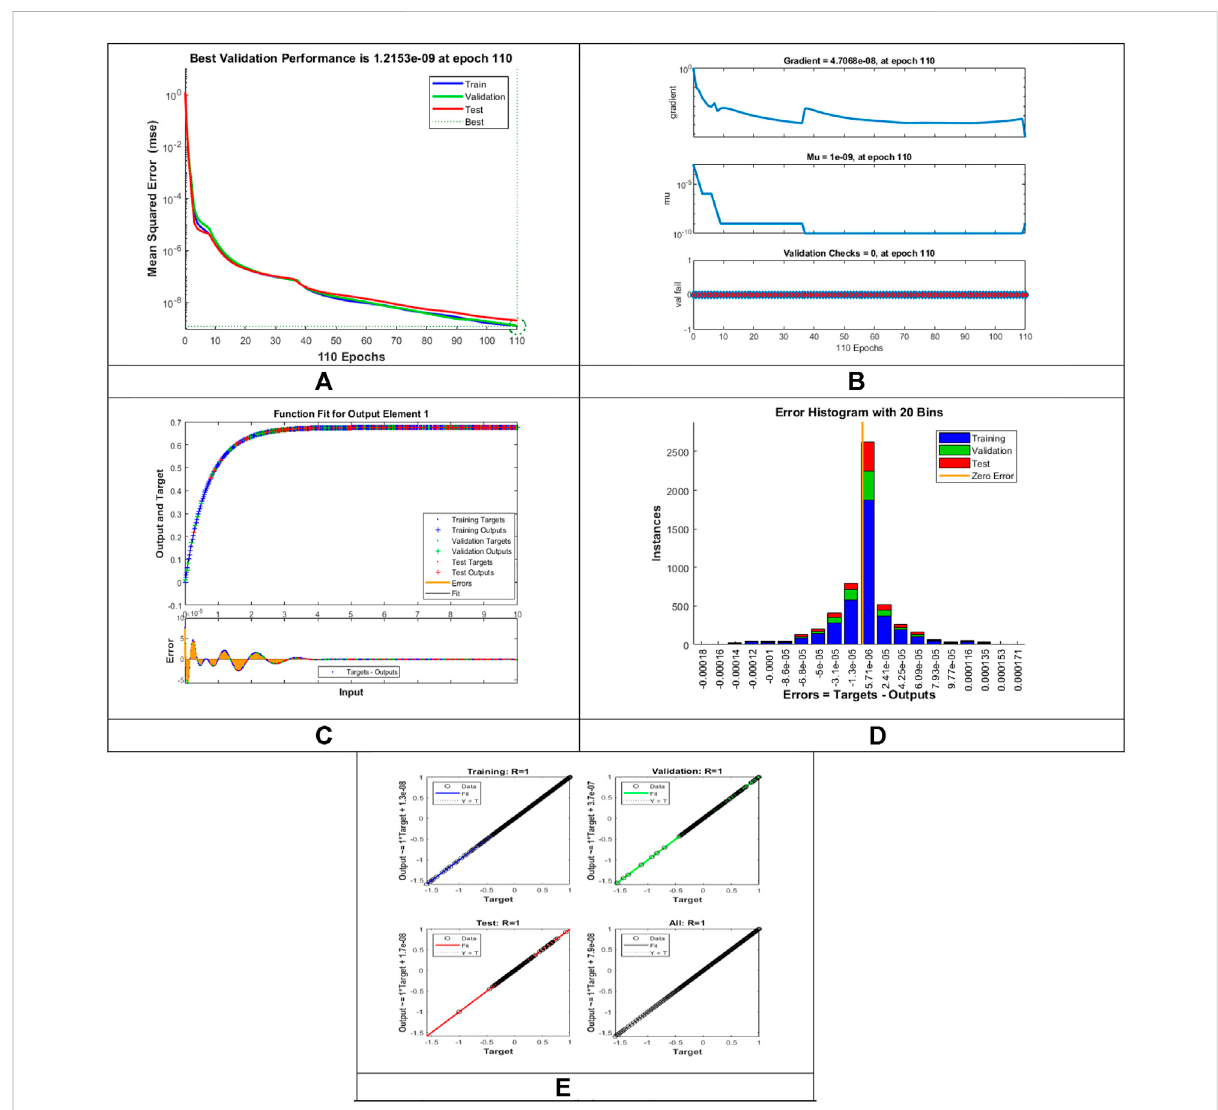
FIGURE 11 PictorialillustrationfortheLMLA-BPNNbaseonvariantsof γ vs ϕ ( η ) forMHD-WNF-HGA. (A) M-S-Edemonstration, (B) transitionstateanalysis, (C) curve fi tting, (D) error histogram, and (E) regression